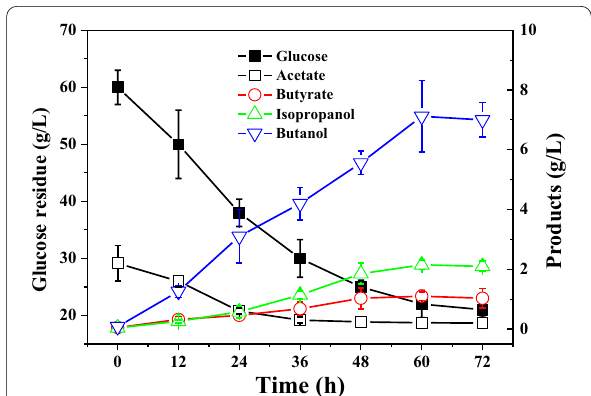
Fig. 2 The glucose consumption and product formation during Clostridium beijerinckii XH0906 batch fermentation